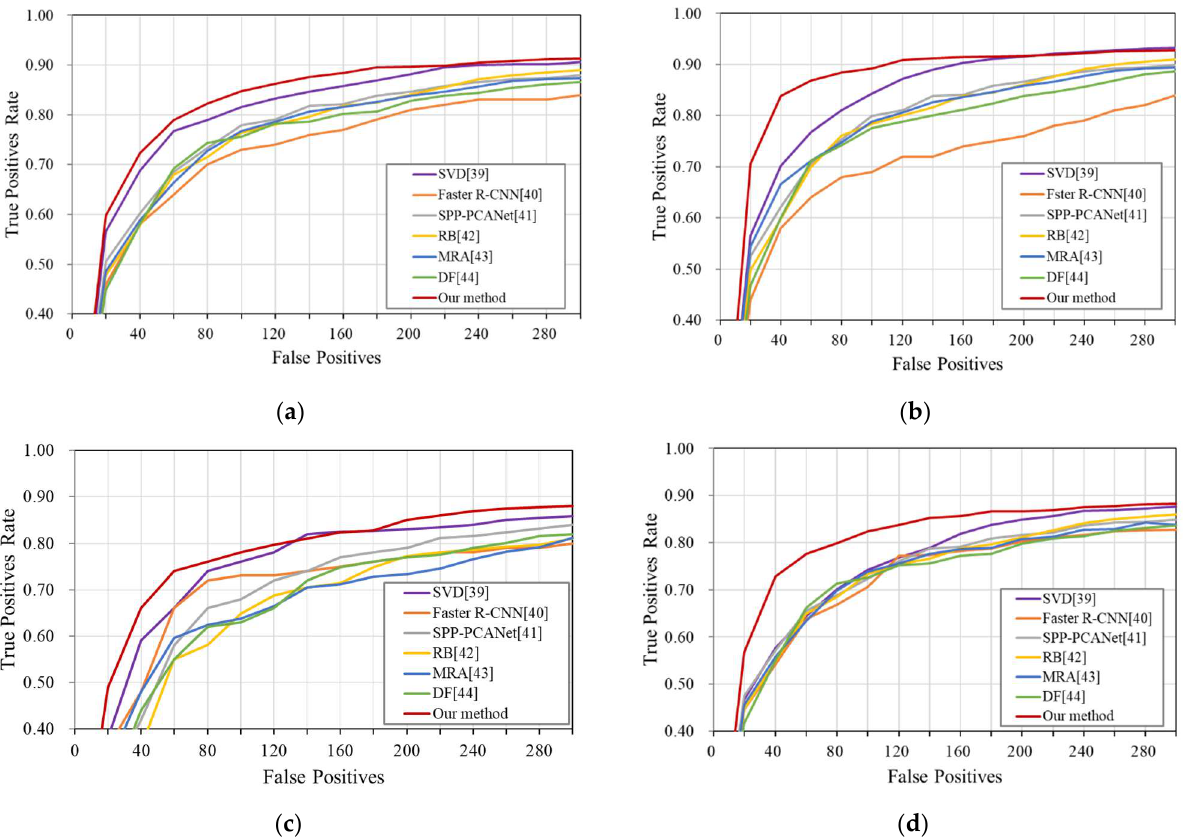
Figure 9. Diagram of false-positive and true-positive rates: ( a ) cloud interference; ( b ) trail interference; ( c ) reef interference; and ( d ) sea-clutter interference.